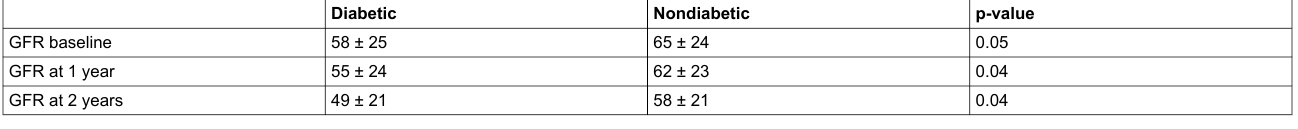
Table 4: Absolute values of glomerular filtration rate (GFR) in diabetic (n = 77) vs nondiabetic (n = 207) patients after 1 and 2 years; changes of GFR after 1 year in diabetics according to baseline CKD stage. Diabetic